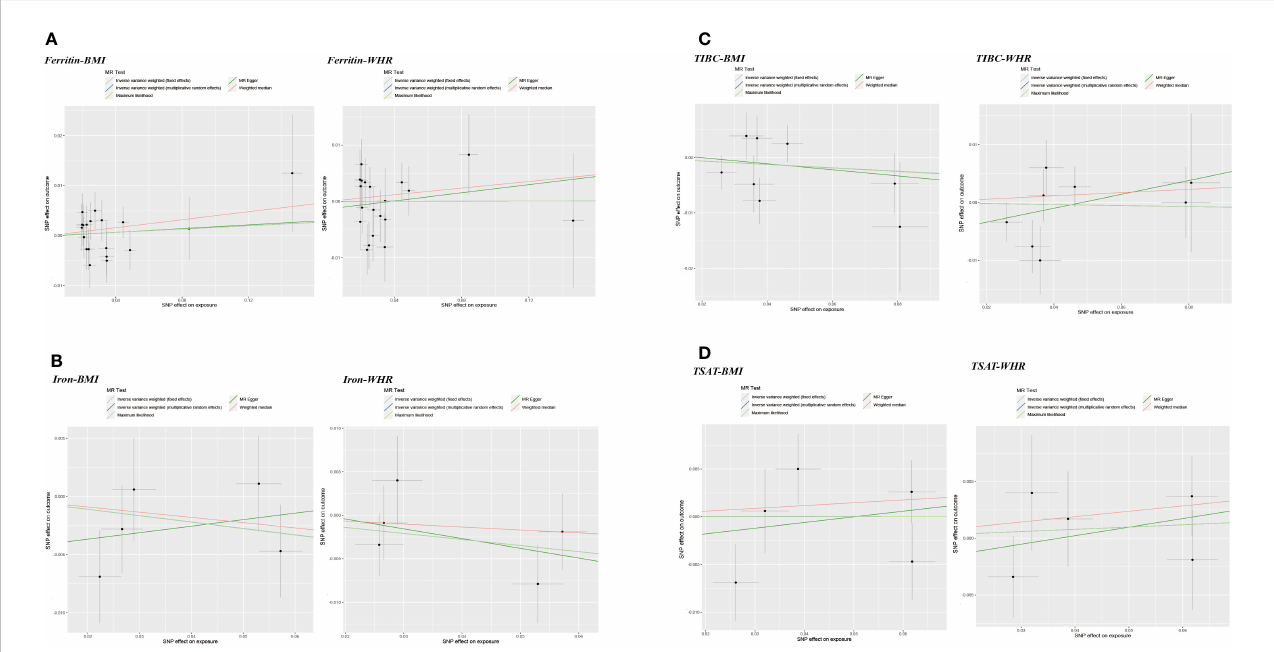
FIGURE 5 Scatter plots of Mendelian randomization analyses of the association between genetically predicted iron status and obesity-related traits. (A) serum ferritin – BMI and WHR; (B) serum iron – BMI and WHR; (C) TIBC – BMI and WHR; (D) TSAT - BMI and